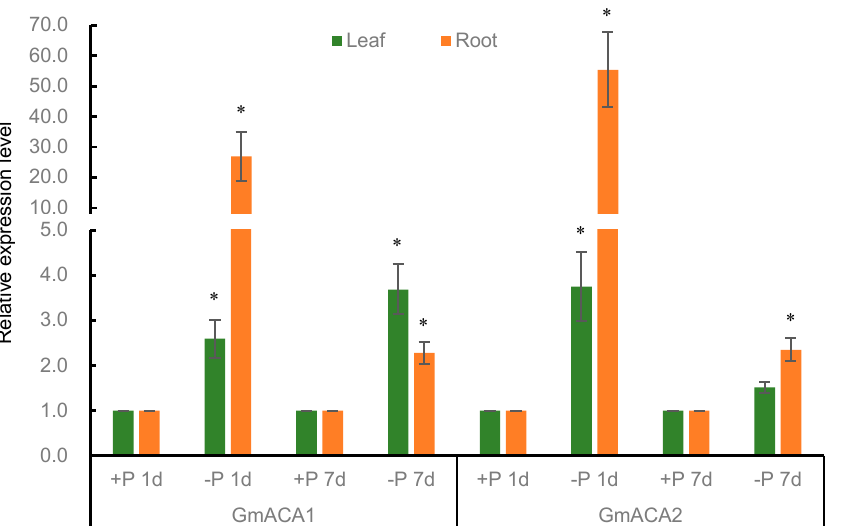
Figure 14. Relative expression levels of GmACA1 and GmACA2 in the roots and leaves of soybean seedlings after phosphorus-deficiency ( − P) treatment for one day (1 d) and 7 days (7 d): the relative expression levels of GmACA1 and GmACA2 in roots and leaves under phosphorus-sufficient conditions (+P) were normalized to one. Relative expression levels of these genes in soybean leaves and roots were detected by qRT-PCR. Data presented are mean ± SD from three biological replicates. The asterisks indicate an absolute fold change > 2 ( − P/+P) and p -value < 0.05 by Student’s t-test.